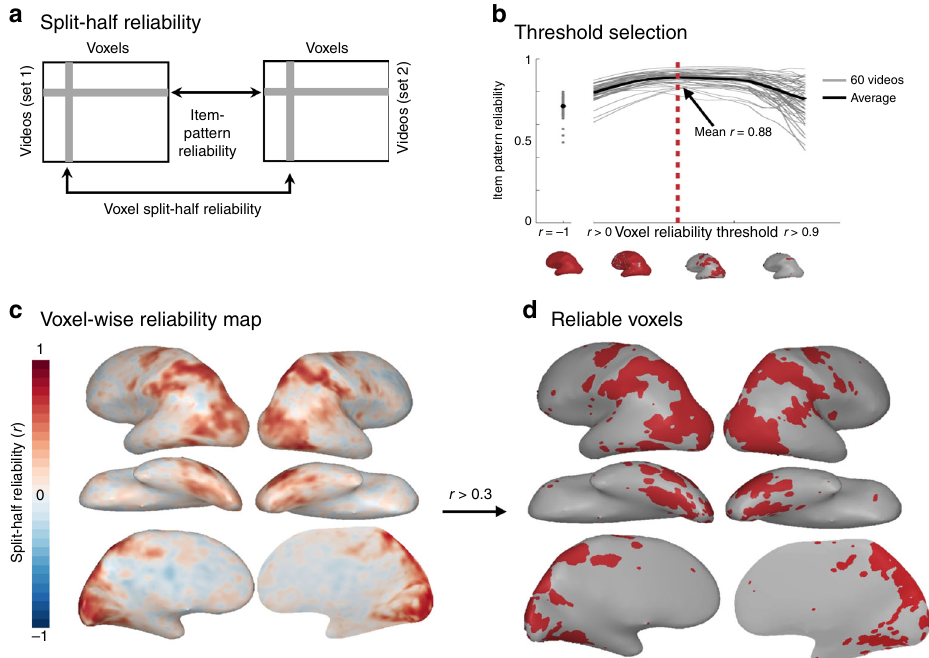
Fig. 1 Reliability-based voxel selection. a Schematic illustrating how voxel split-half reliability and item-pattern reliability were calculated from whole-brain response data. b Plot of average item-pattern reliability (split-half reliability of each item ’ s multi-voxel pattern; y -axis) among voxels that survive a range of reliability cut-offs ( x -axis). Brains along the x -axis display the voxels that survive the reliability cut-offs at r = − 1, 0, 0.35, and 0.7. c Whole-brain map of split-half voxel reliability. d Reliable voxels ( r > 0.30) selected based on the point where the curve plotted in ( b ) begins to plateau (see Tarhan and Konkle 26 for details). These results are based on group data. All analyses were conducted over reliable voxels, which were selected using the procedure outlined here. All brain fi gures were created by the